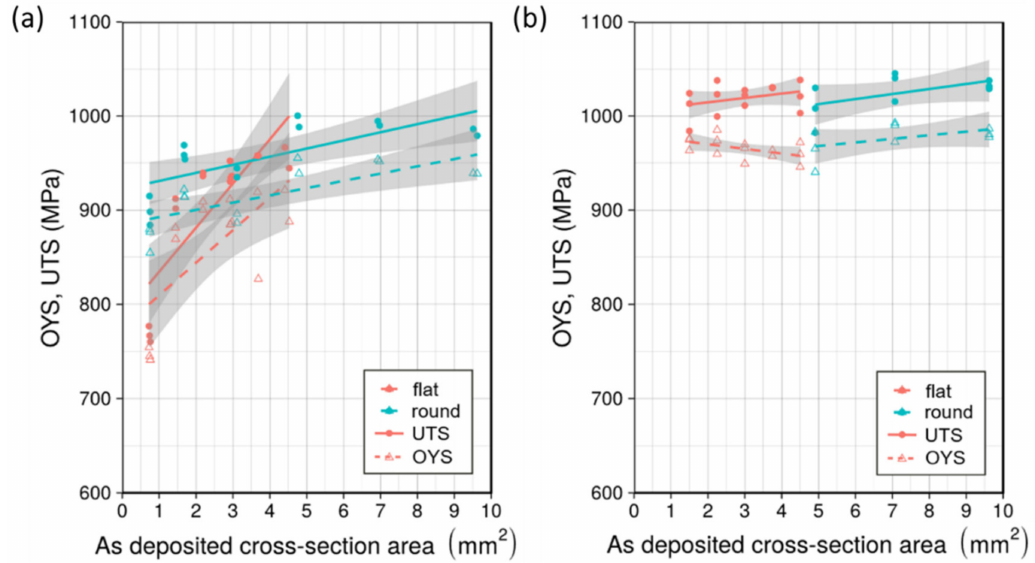
Figure 7. Average values for OYS and UTS with standard deviations for: ( a ) as-deposited SLM flat and round specimens, ( b ) machined SLM flat and round